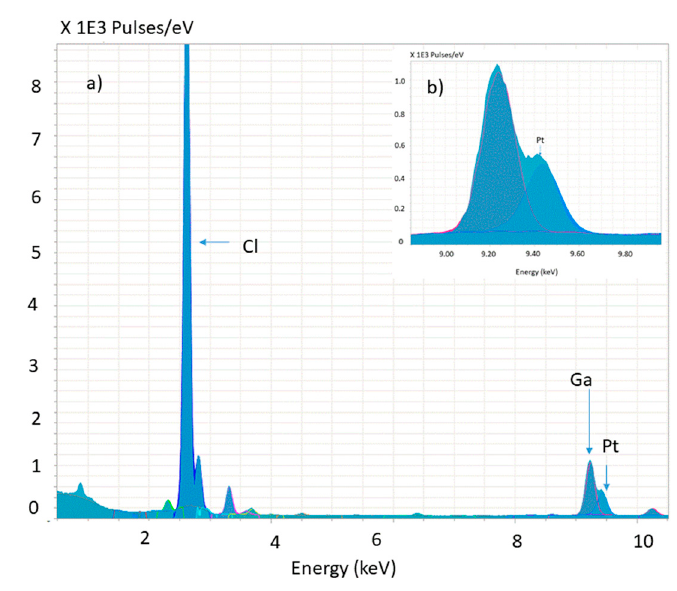
Figure 3. ( a ) TXRF analysis of the PVC-PtOEP MPs confirming the presence of Pt into the particles. Ga is present as the internal standard. ( b ) inset of the peak related to the Pt.